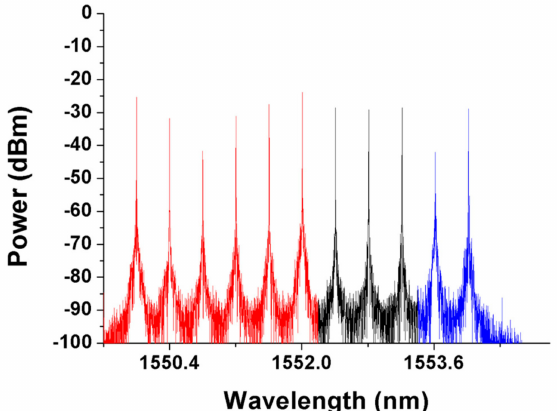
Figure 11. Routing pathways of the downstream detection signals when the first phase of the second detection step is executed.